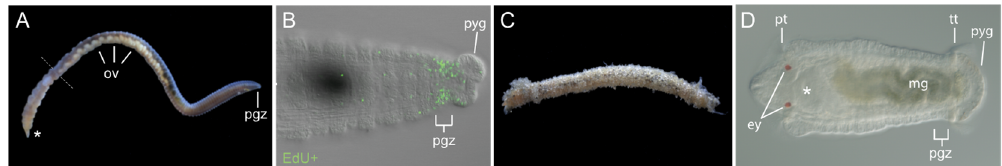
Figure 2. The annelid Capitella teleta . Anterior is to the left in all panels. ( A )Adult C. teleta female showing the segmented body organization. Dotted line indicates the boundary between thoracic and abdominal segments. Ovaries present in abdominal segments are visible through the body wall (ov). ( B ) Close up view of the posterior end of a juvenile. Image shows the posterior growth zone (pgz), a localized region of dividing cells that generates segments throughout the lifespan. Green indicates cells in the S-phase of the cell cycle that have incorporated EdU (EdU+). ( C ) Brood tube containing female and embryos. ( D ) Late-stage larva with approximately 13 segments. Shown is a ventral view. Asterisk indicates position of the mouth in panels A and D. Abbreviations: ey, eye; mg, midgut; ov, ovaries; pgz, posterior growth zone; pt, prototroch; pyg, pygidium; tt, telotroch.